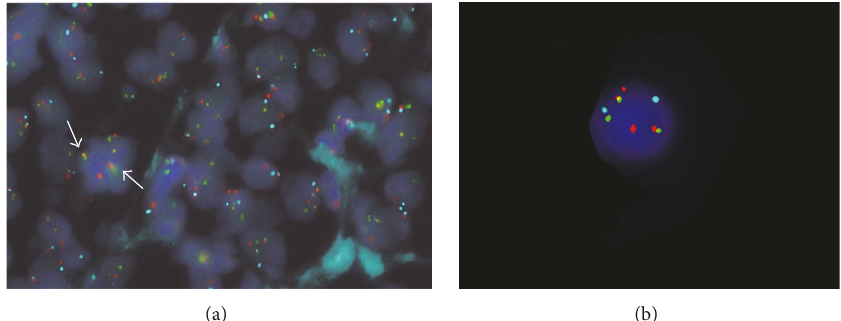
Figure 6: CEP8/MYC/IGH probes on tonsils (a) and bone marrow biopsy (b). The FISH analysis was performed using probes from Vysis; MYC-Orange spectrum, CEP8-Aqua spectrum, and IGH-Green spectrum. White arrows indicate the fusion signal a result of MYC/IGH